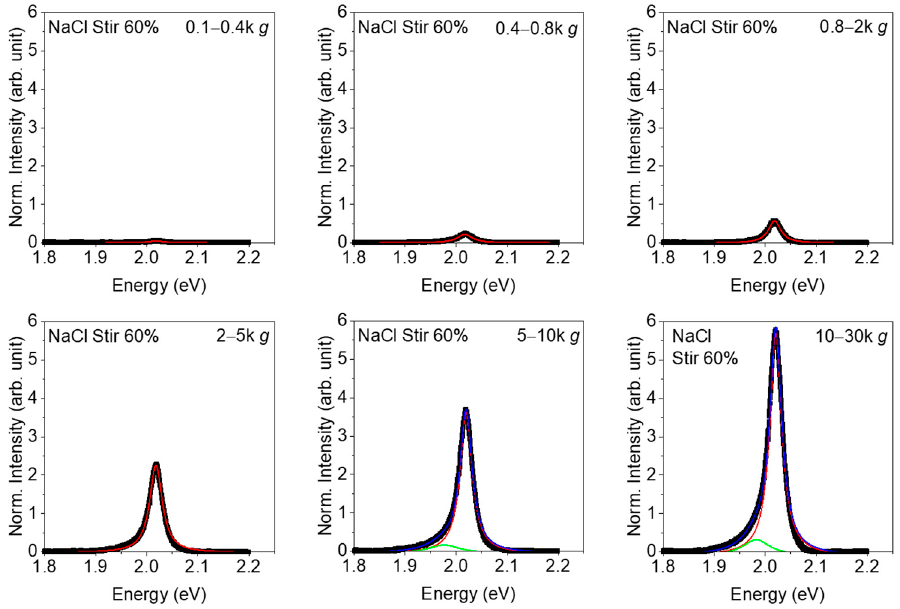
Figure A12. Photoluminescence spectra ( λ ex c = 532 nm) the WS 2 nanosheet dispersions, exfoliated by tip sonication with a 60% amplitude. The bulk starting material was stirred in H 2 O/NaCl prior to exfoliation. The PL was fitted by Lorentzians for quantitative analysis.